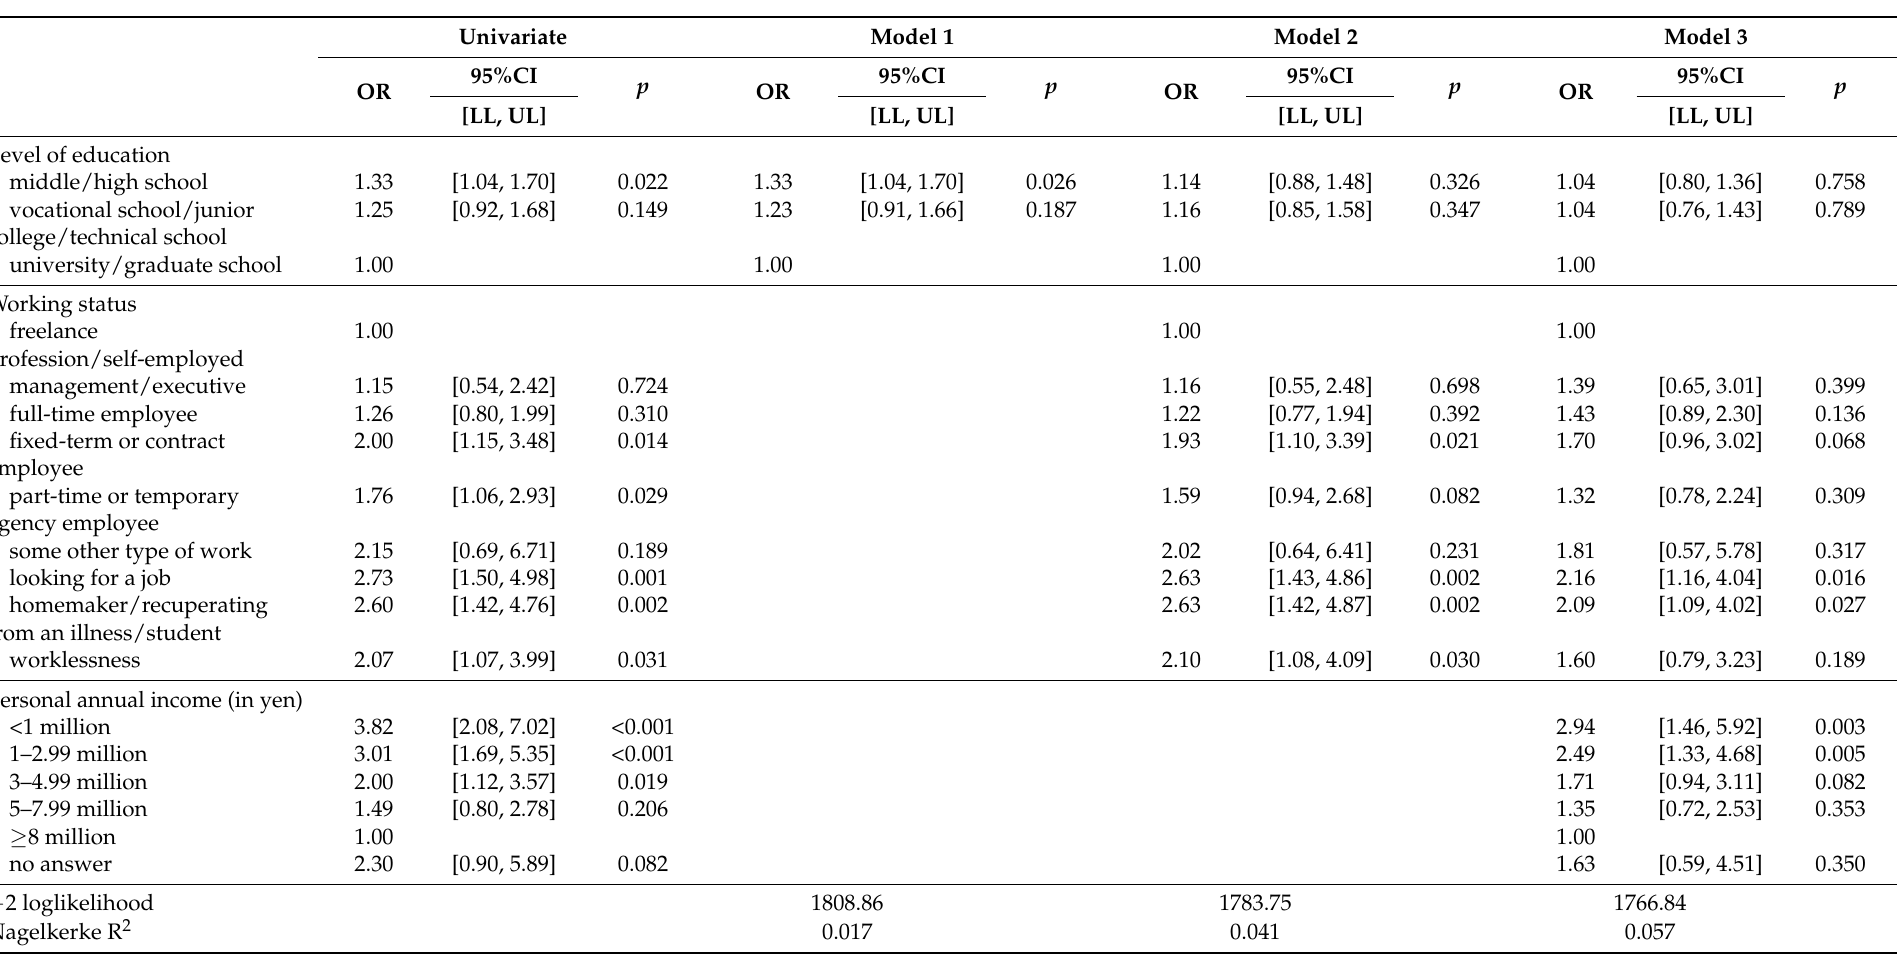
Table 3. Logistic regression analysis about relationships between socioeconomic status and low sense of coherence among Japanese people living with HIV/AIDS. Univariate Model 1 Model 2 Model